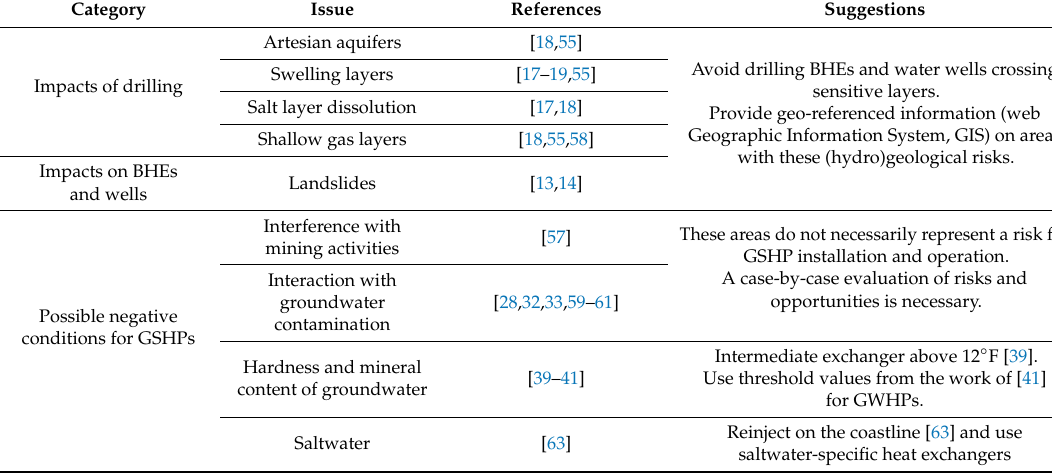
Table A1. Summary of environmental concerns for the installation of ground source heat pump (GSHP) systems with related literature references and suggestions to address them. BHE,